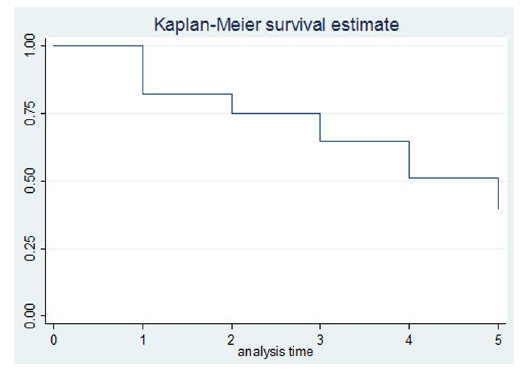
Figure 2: Kaplan Meier 5-year survival curve for patients listed in 2009.